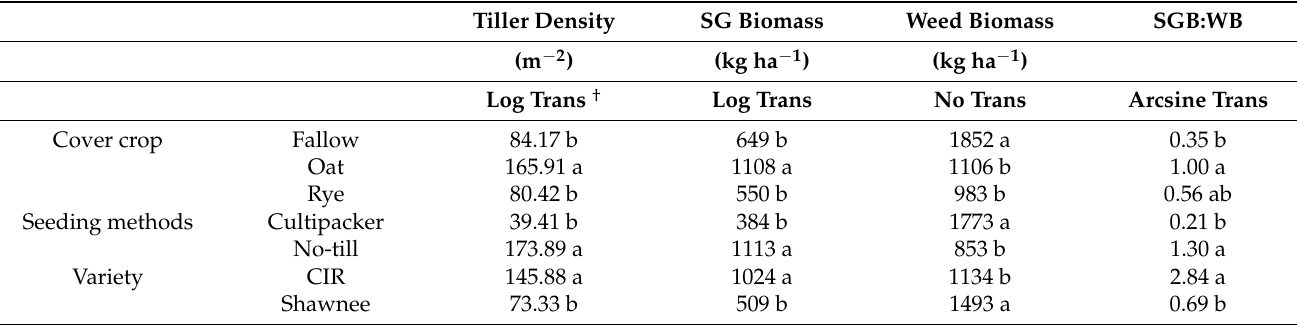
Table 2. Influence of cover crop, seeding method and switchgrass variety on switchgrass (SG) tiller density and biomass, weed biomass, and switchgrass/weed biomass ratio (SGB:WB) in the 2012 growing season.